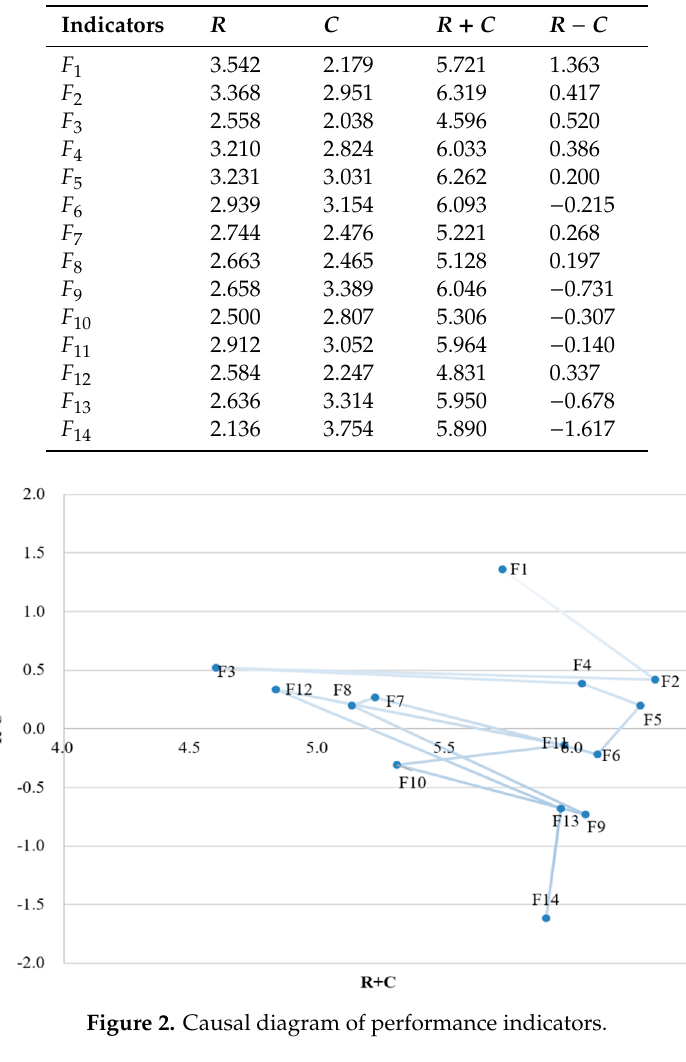
Table 8. Sum of influences given and received for each performance indicator.